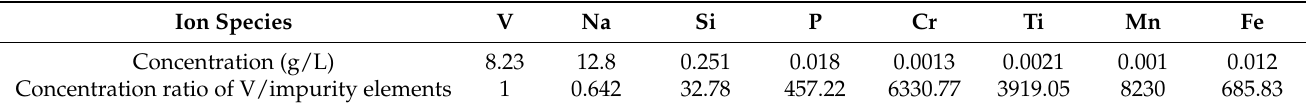
Table 2. Concentration of main ions in vanadium leaching